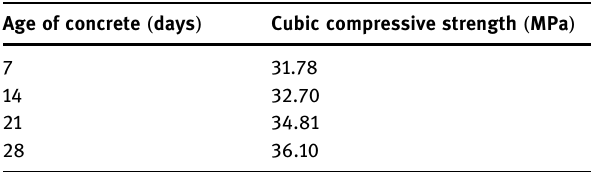
Table 6: Cubic compressive strength of di ff erent ages Age of concrete ( days )